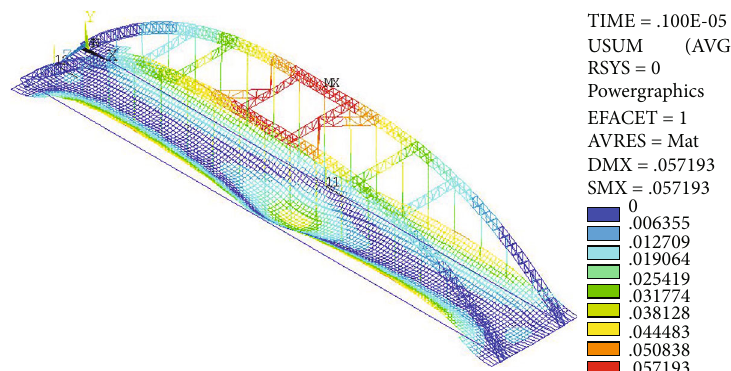
Figure 15: The overall displacement cloud map of arch bridge under case 7 (m).